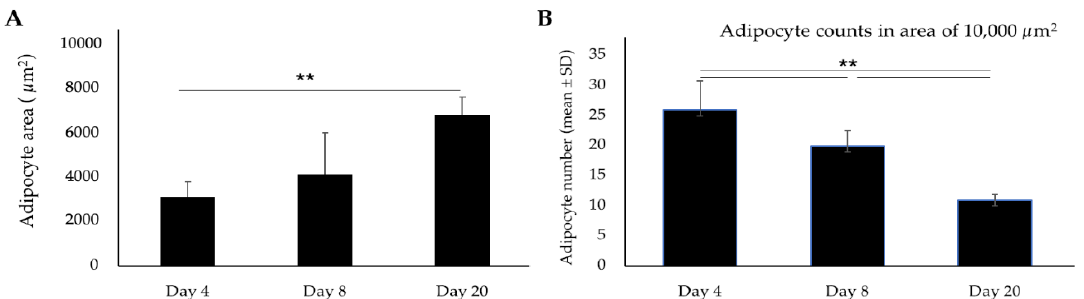
Figure 2. Measurement of proliferation and size of porcine adipocyte during long-term adipogenic differentiation. ( A ) The average area (size) of the adipocytes. ( B ) Average count of Oil red O stained (live) adipocytes. Images of stained adipocytes were analyzed for size and number of cells using ImageJ software. Data shown are the mean ± SD of three independent experiments performed in triplicates. The asterisks (**) indicated statistical differences of adipocyte number and size when compared with Day 4 at the significance level of p < 0.01.